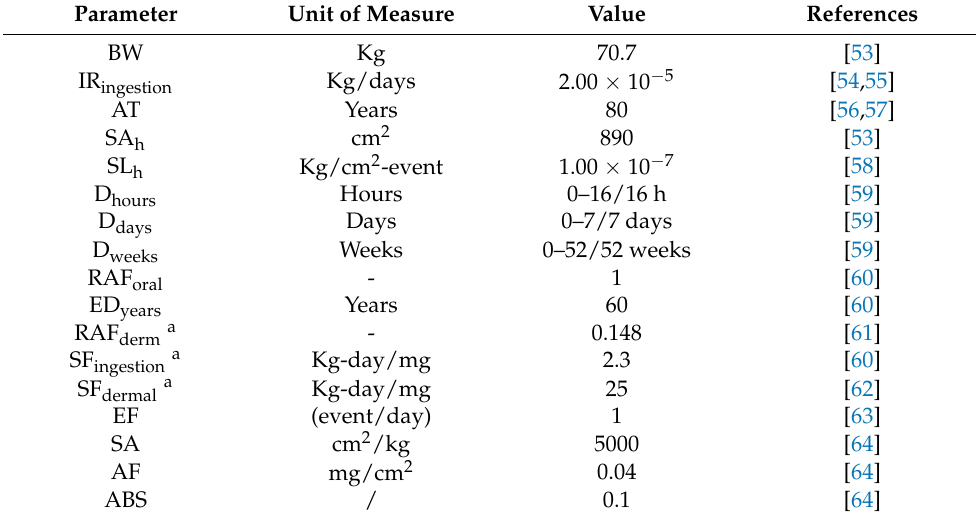
Table 6. Parameters used for the calculation of doses taken up by human receptors through different routes of